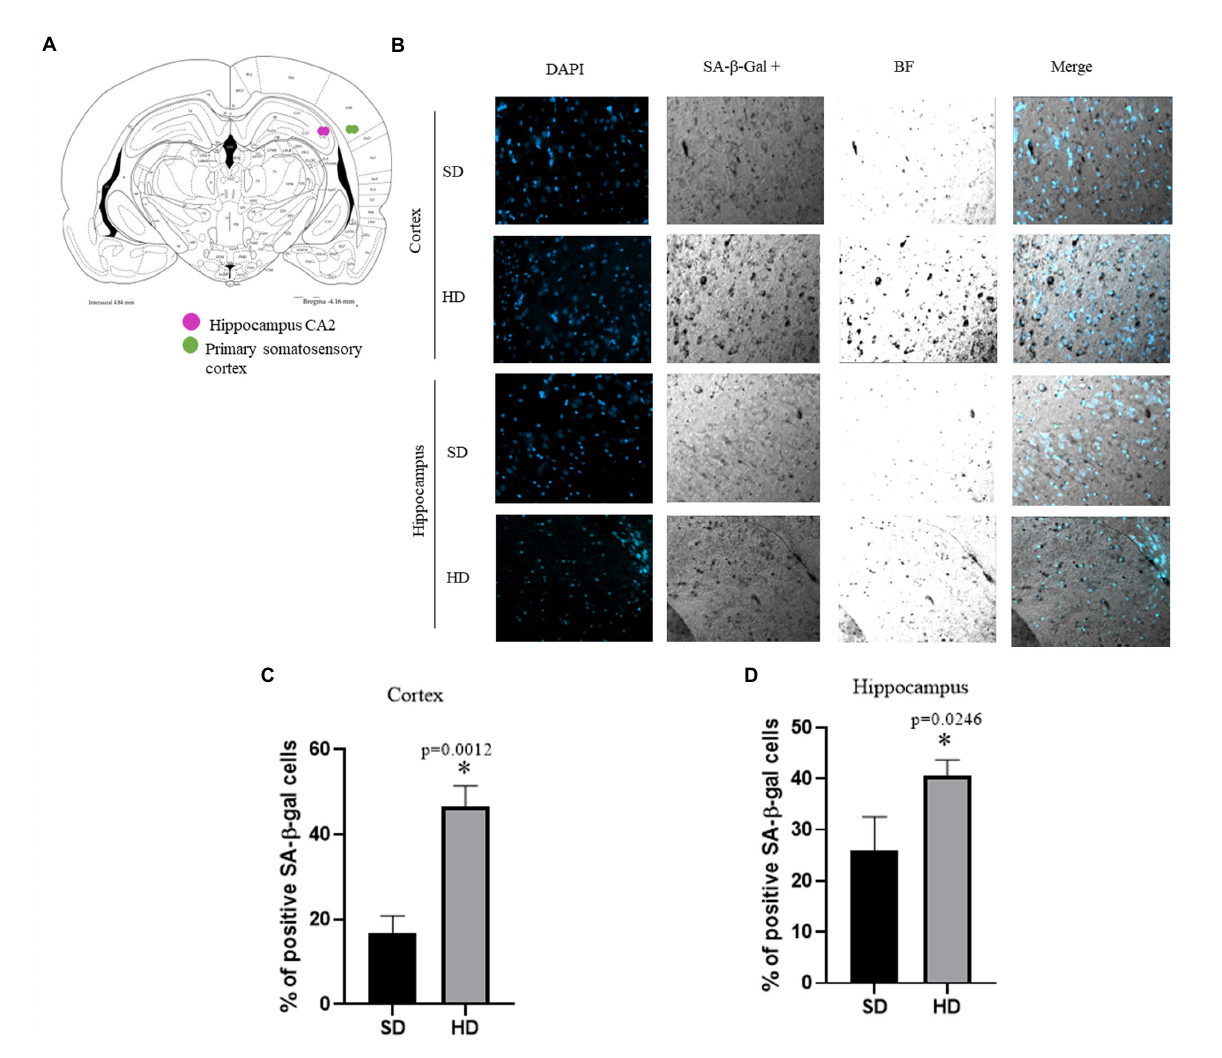
FIGURE 8 Evaluation of senescent cells in brain. (A) Anatomic diagram to locate the regions analyzed. (B) Representative images of different regions with cells with senescence features accumulate in the Cx and Hc in animals with HD at 13 months ( n = 6 SD and n = 6 HD). The percentage of SA- β -gal positive cells per area in each brain section in cortex (C) and hippocampus (D) . The average of three brains per group is graphed. The data represent the mean ± SD and were analyzed by two-way ANOVA, followed by Tukey’s post hoc test. The significant differences between groups compared to the SD are marked with ∗ and differences at different ages are marked with & p < 0.05. Confocal fluorescence micrographs are 20× magnification. n =